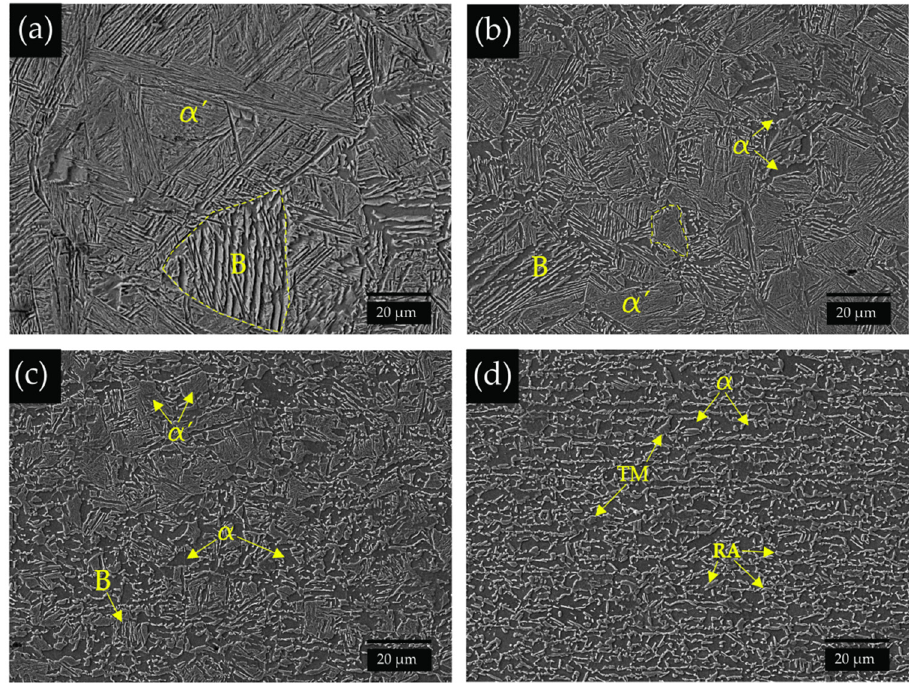
Figure 5. Microstructure development along the HAZ of the TRIP steel side: ( a ) UC-HAZ coarse grain, ( b ) UC-HAZ fine grain, ( c ) IC-HAZ, ( d ) SC-HAZ. Macrographs captured from the dissimilar TRIP-DP GMAW specimen.